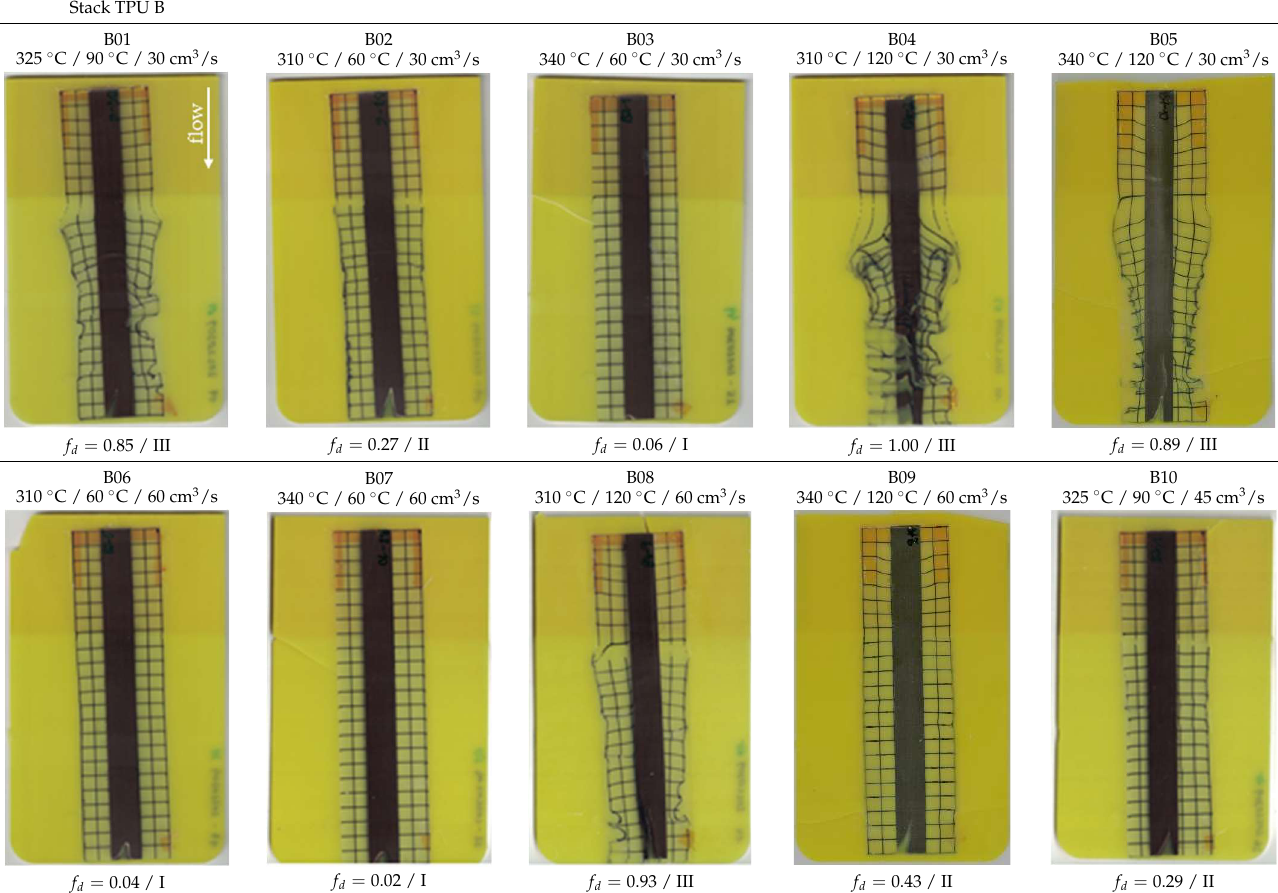
Table 2. Images of the overmolded films using TPU B for molding settings as outlined in Table 1. The associated distortion factor f d and damage category (I–III) are given below each image.